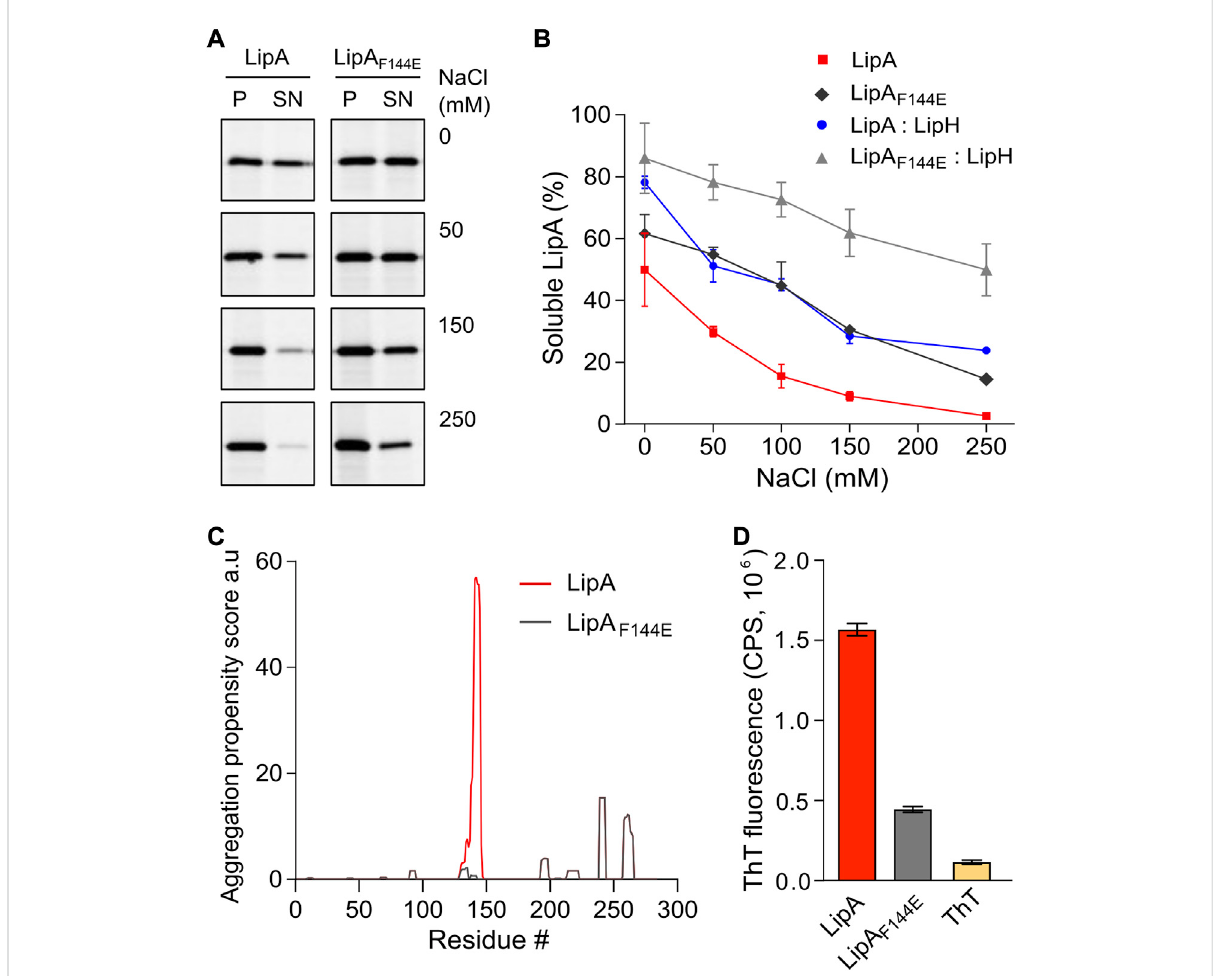
FIGURE 2 LipA aggregation propensity is sensitive to the environment and the structure of the lid domain. (A) SDS-PAGE of the aggregated and soluble LipA variants separated into the pellet (P) and the supernatant (SN) fractions, respectively, upon centrifugation. The concentrations of NaCl in the buffer are indicated. For the in-gel fl uorescence detection, the lipases were labelled with fl uorescein-5-maleimide. (B) Quanti fi cation of the soluble LipA at various conditions. The fraction of the soluble wild-type LipA and the mutant LipA F144E at various salt concentrations and, optionally, in presenceofLipHwascalculatedfromSDS-PAGE(panelA).Theassayswereperformedintechnicaltriplicates,themeanvaluesandSDareshown. (C) Sequence-based prediction of LipA aggregation propensity by TANGO algorithm (Fernandez-Escamilla et al., 2004). Pro fi les for the β -aggregation propensity scores of the wild-type LipA (red) and the mutant LipA F144E (grey) indicate the aggregation-prone regions within the polypeptide chain. The aggregation propensity of thewild-type LipA is dominated by the α -helix 5that forms the lid domain. (D) LipA aggregation is associated with the formationof β -structuredamyloid-likeaggregates.Theintensityoftheamyloid-sensitiveThT fl uorescenceat485 nmwasmeasuredinthepresence of either the wild-type LipA (red), the mutant LipA F144E (grey), or the dye alone (yellow). The assays were performed in technical triplicates, the mean values and SD are